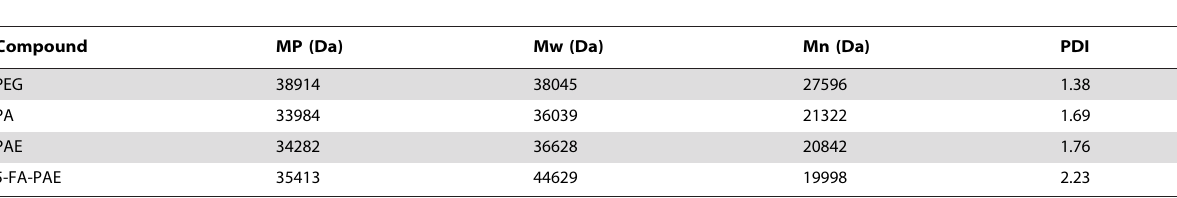
Table 1. The molecular weight of the polymeric carrier (PEG, PA, PAE) and the prodrug (5-FA-PAE).